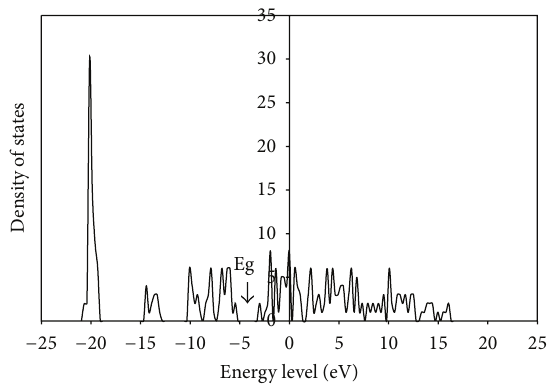
Figure 8: Density of states of InSb-hexamantane as a function of energy levels.